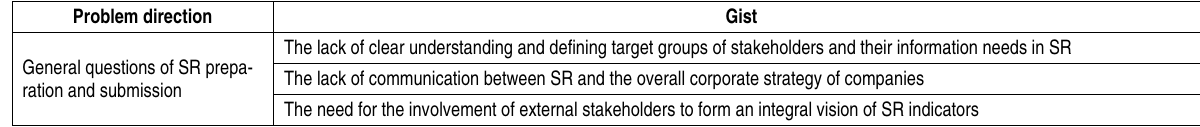
Table 1. Problematic areas of SR